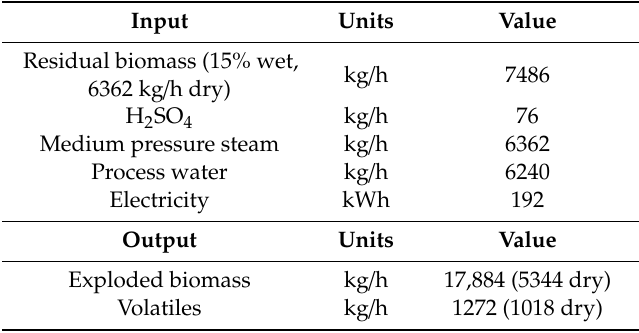
Table 4. Input and output data for the steam explosion pretreatment process.